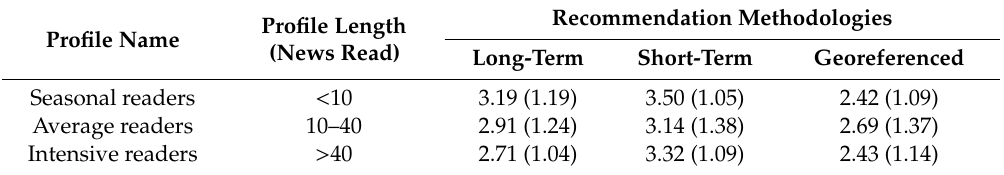
Table 4. Experiment 2: Average ratings (standard deviation) preferences considering di ff erent news consumption